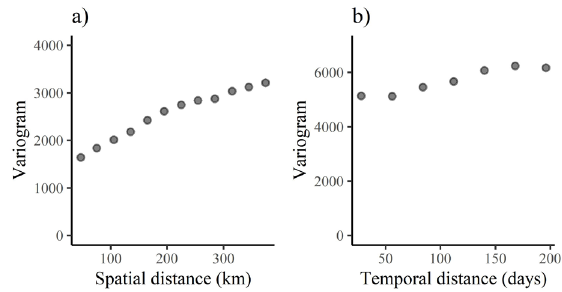
Figure 8. Maps of estimated precipitation in SFRB for all months of the year 2019.